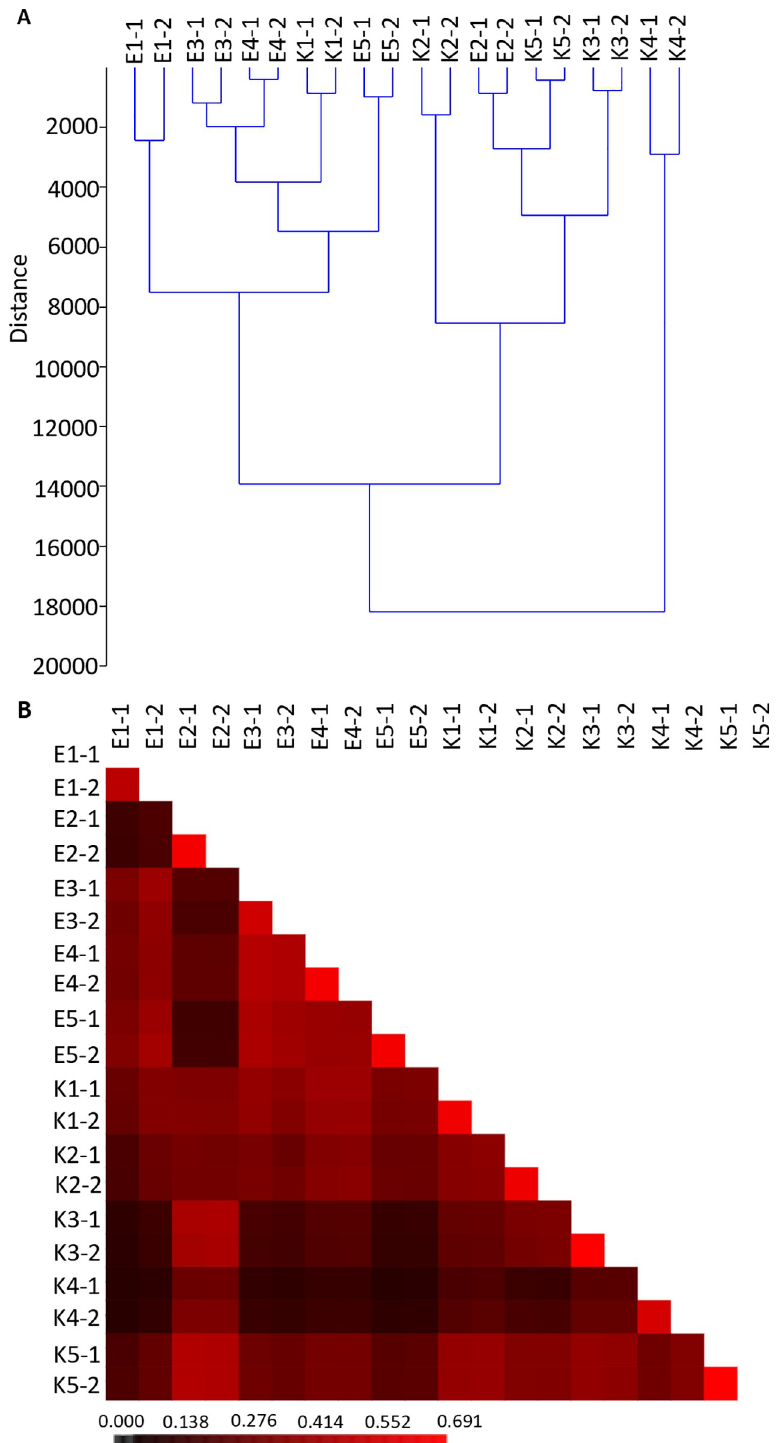
Fig 4. β -diversity between bacterial communities in tested samples. UPGMA dendrogram (A) was constructed in PAST software using Ward’s method and heatmap (B) was built in Mothur based on Bray-Curtis distance. Labels along the left and top sides of heatmap and the upper side of dendrogram represent individual soil samples. Each square within the heatmap represents a single pairwise comparison between the samples. The color code, as indicated by the bar below, represents the similarity of the samples, where darker color represents more dissimilar and brighter indicates more similar communities. Distance trees and heatmaps were constructed at distance of 0.03. https://doi.org/10.1371/journal.pone.0256969.g004 PLOS ONE | https://doi.org/10.1371/journal.pone.0256969 September 9,